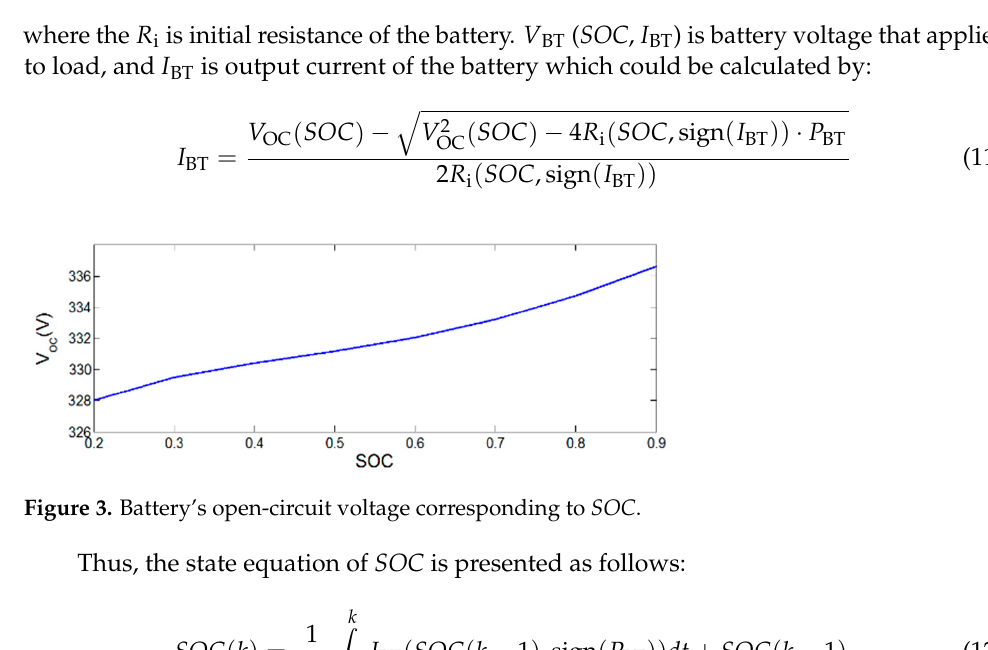
is connected with F-MCU and R-MCU by CAN bus.